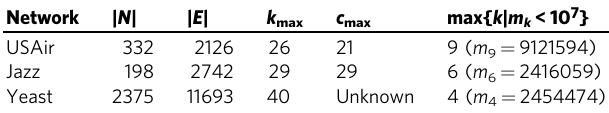
Table 1 Three real networks: their sizes (number of nodes | N | and number of edges | E |), maximum coreness k max , the maximum number of cliques c max , number of k -cliques m k , and the maximum order k of cliques with their nu m bers m k < 10 7